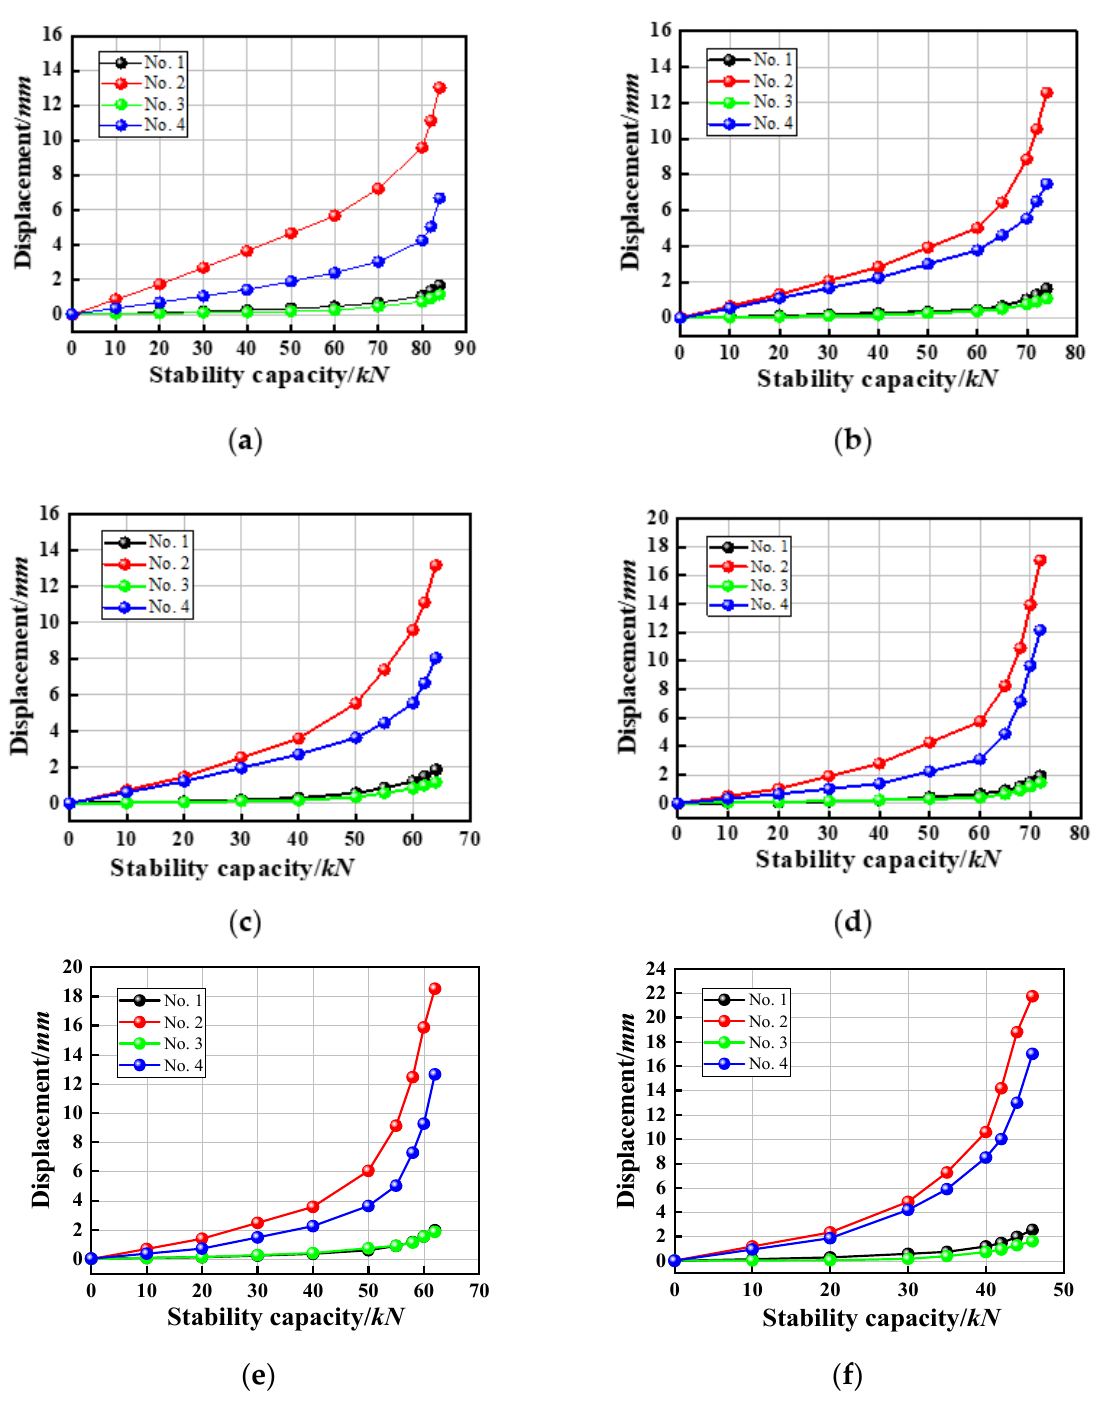
Figure 27. Load ‒ displacement curves of measuring points: ( a ) Single-layer central pole; ( b ) single- layer side pole; ( c ) single-layer corner pole; ( d ) double-layer central pole; ( e ) double-layer side pole; ( f ) double-layer corner pole.